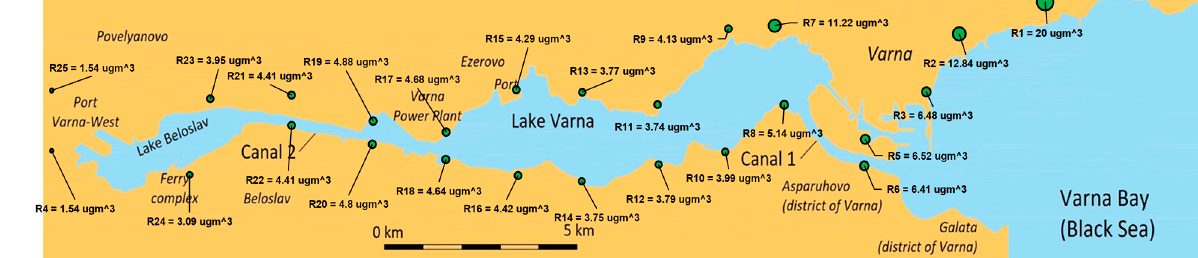
Figure 10. Air pollution, μ g/m 3 at receptors R 1 to R 25 , after ship emission cleaning, 𝑁𝑂 (cid:2934) .